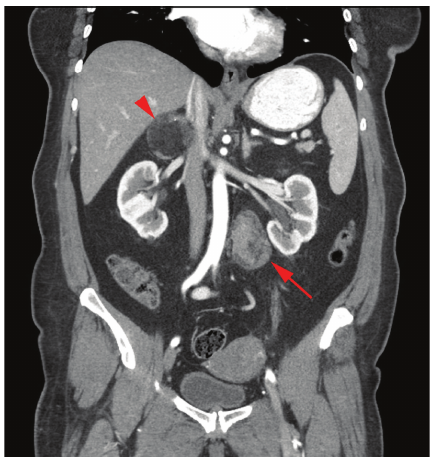
Figure 1: Coronal image from contrast enhanced CT of the abdomen/pelvis. A heterogeneous soft tissue mass is seen in the left para-aortic retroperitoneum, inferior to the renal hilum (arrow). A predominantly fat containing right adrenal mass is also noted with punctate calcifications (arrowhead). The left adrenal gland is